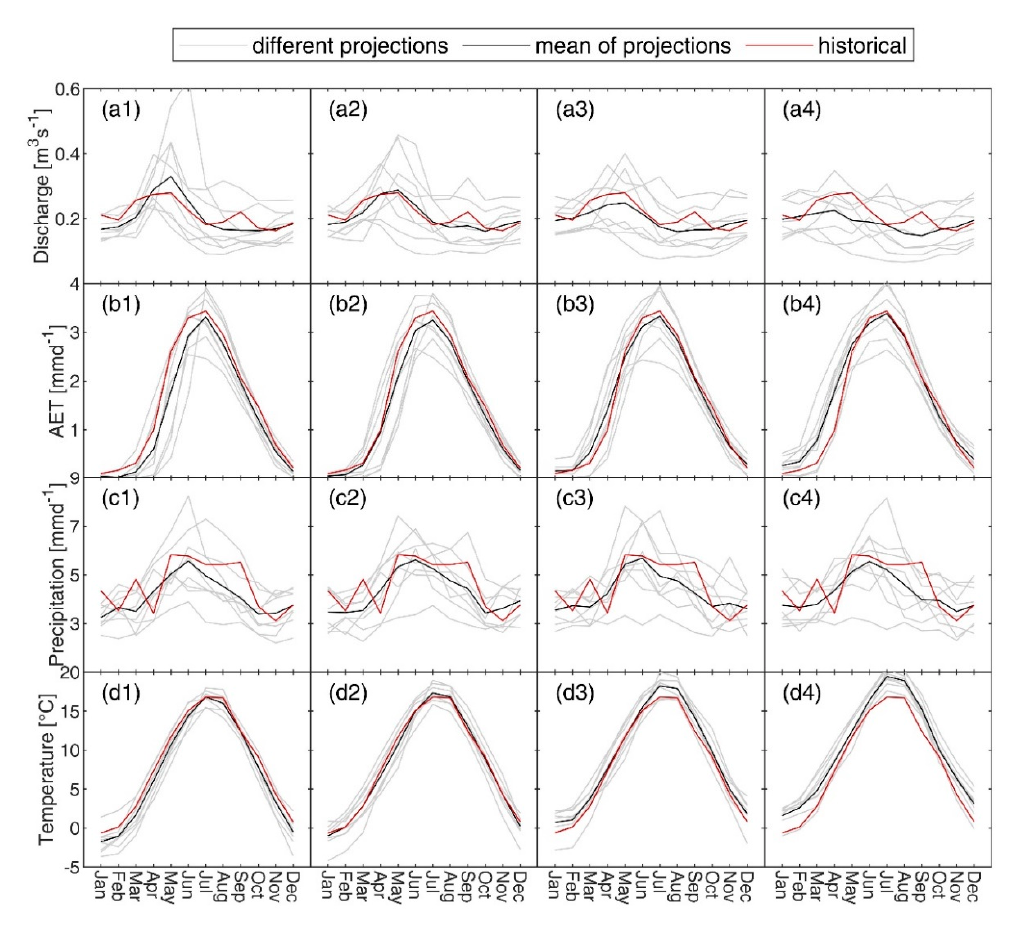
Figure 7. Comparisons between historical and projected mean monthly ( a ) discharge, ( b ) actual evapotranspiration, ( c ) precipitation, and ( d ) temperature, where the number 1–4 represent the four projected time periods: 2021–2040, 2041–2060, 2061–2080, and 2081–2100, respectively. The red line shows the historical simulations (discharge, AET) or observations (precipitation, temperature) for 1994–2019. The black line indicates the mean of the simulations obtained from the eight climate projections while the grey lines represent the results from the individual climate projections.